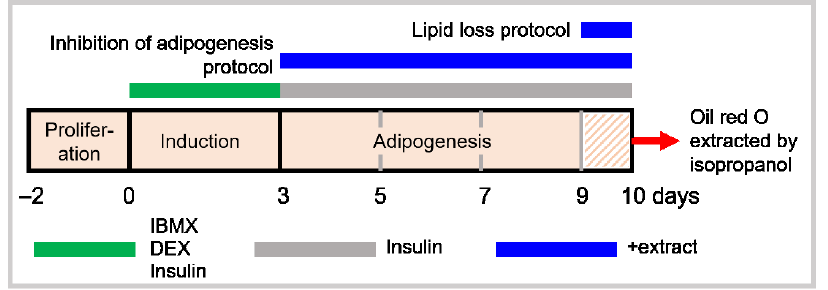
Figure 1. A schema outlining the two protocols. 3T3-L1 cell differentiation into adipocytes was